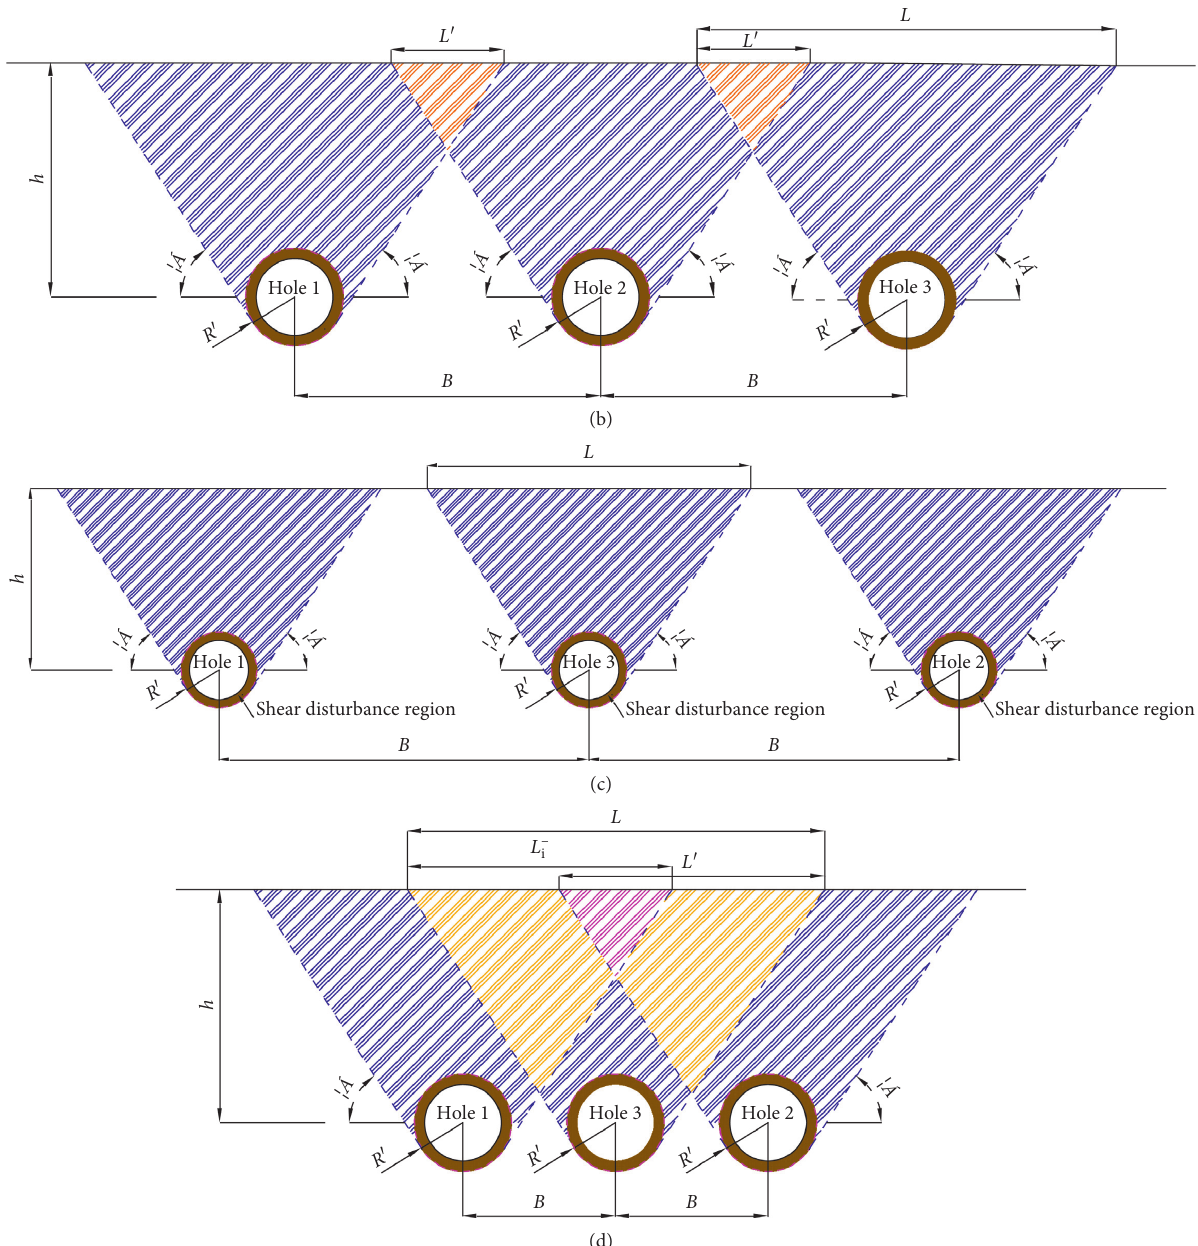
Figure 4: Schematic diagram of lateral disturbance range of three-hole pipeline jacking. (a) The third hole is located on the outside of the previous two holes and the center spacing is large. (b) The third hole is located on the outside of the previous two holes and the center spacing is small. (c) The third hole is located in the middle of the previous two holes and the center spacing is large. (d) The third hole is located in the middle of the previous two holes and the center spacing is